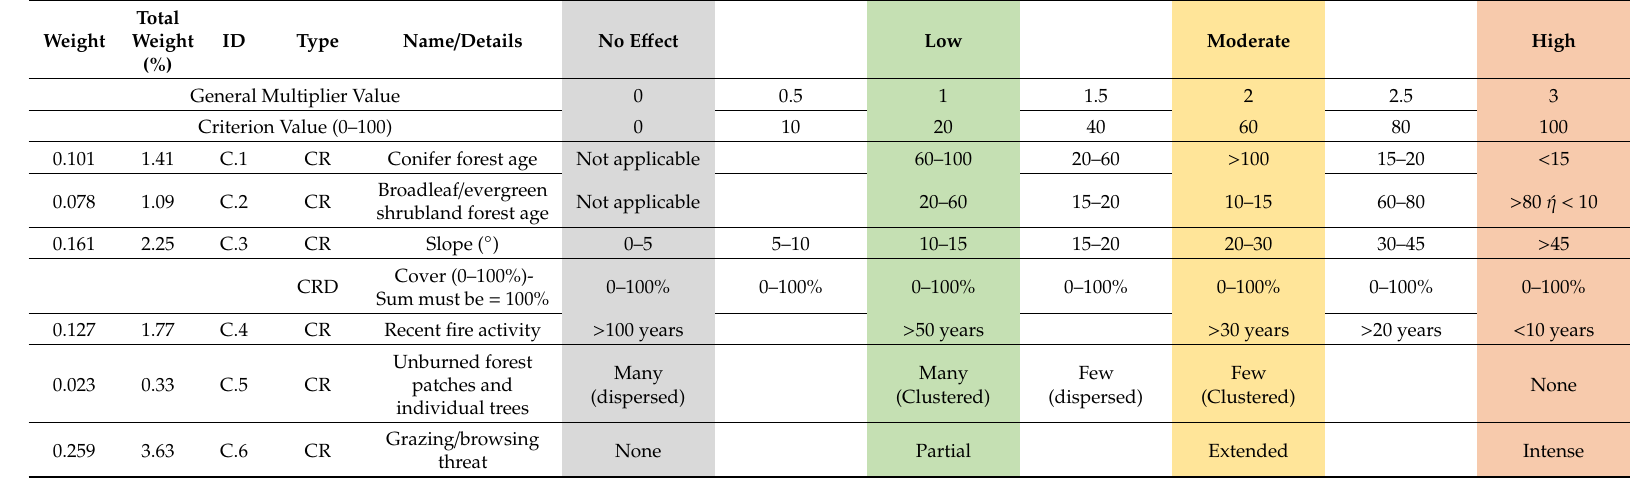
Table A3. Criteria, choices, and weights for the regeneration potential and vegetation recovery fire e ff ects category. CR: criterion; CRD: criterion descriptor; GM: general multiplier. Light gray: Choices with no e ff ect; Dark gray: N / a, denotes a non-applicable or not available selection; Green: Choices with low e ff ect; Yellow: Choices with moderate e ff ect; Red: Choices with high e ff